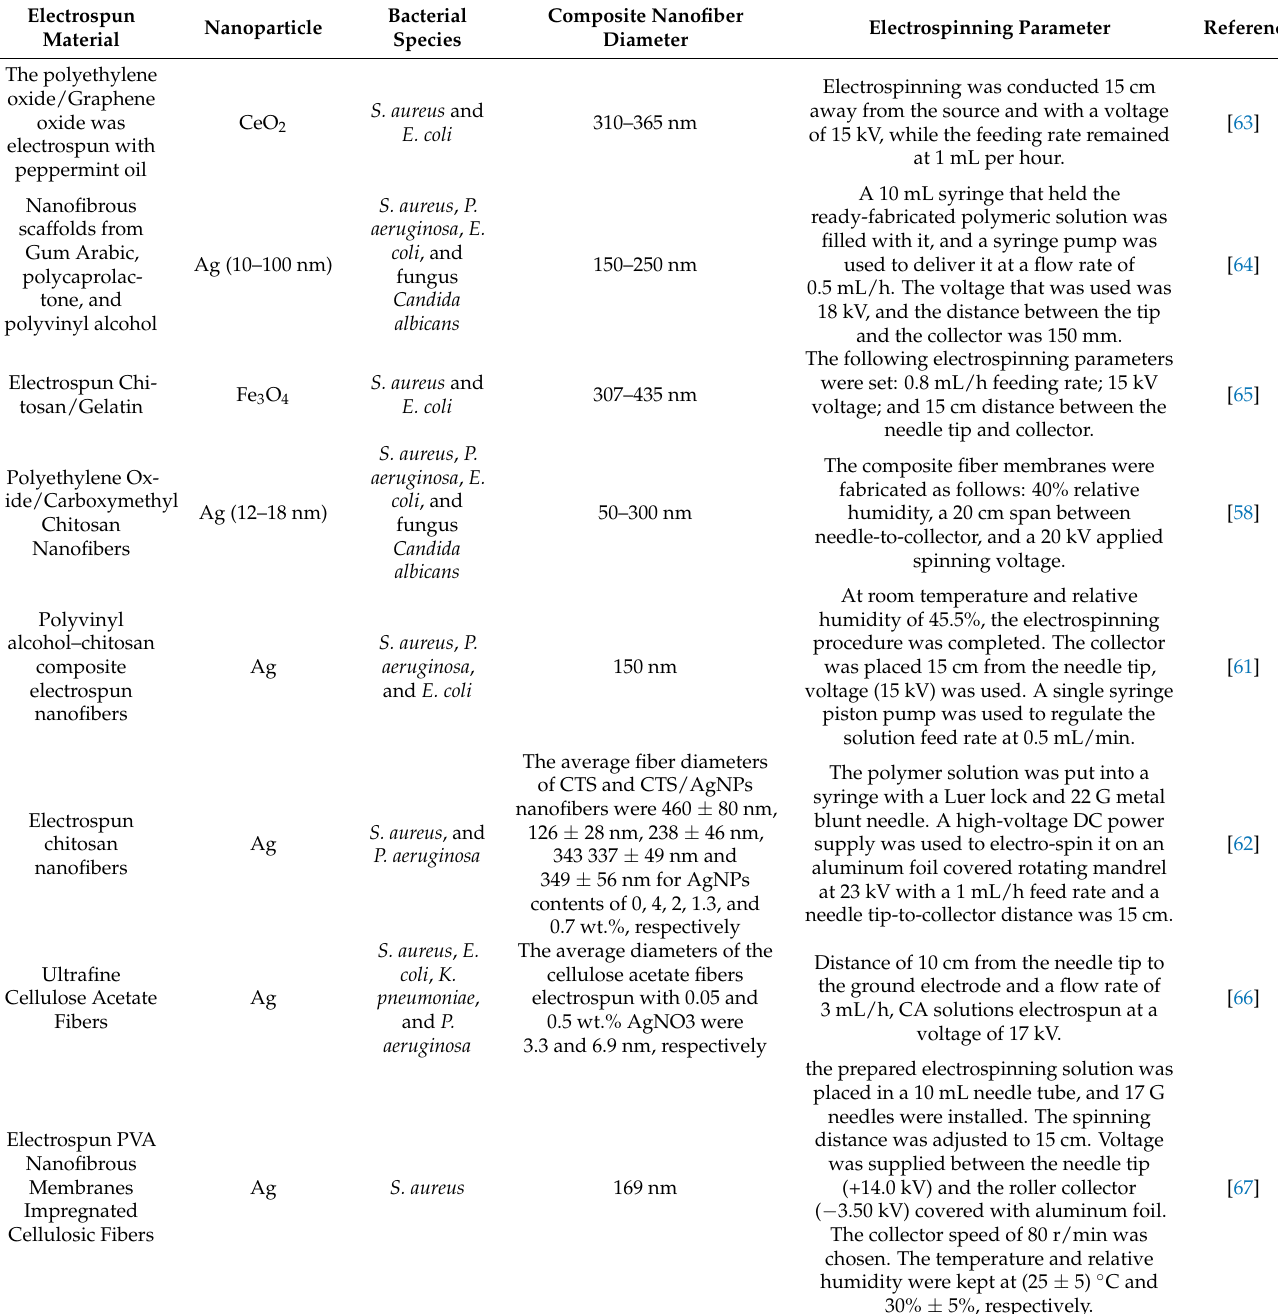
Table 2. An overview of recent nanoparticles and nanomaterials-based wound